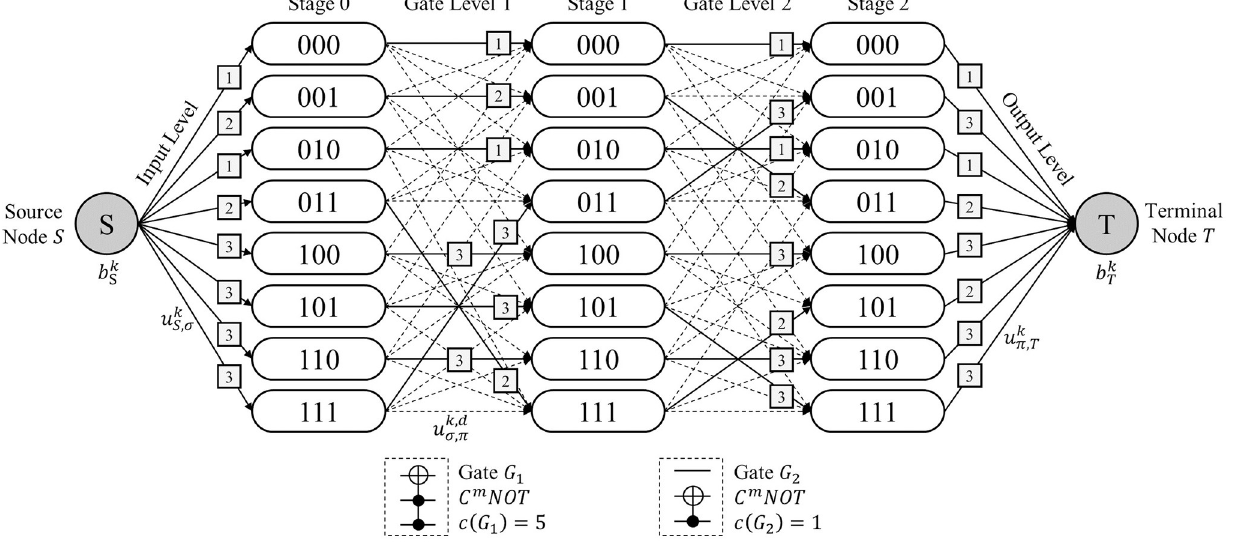
Fig 9. Network representation of MCT circuit for function F 2 .